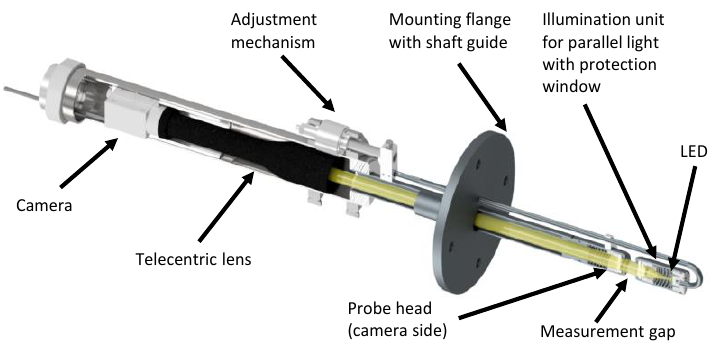
Figure 2. Endoscopic probe at laboratory scale. The mounting flange is adaptable to DN40 or larger.